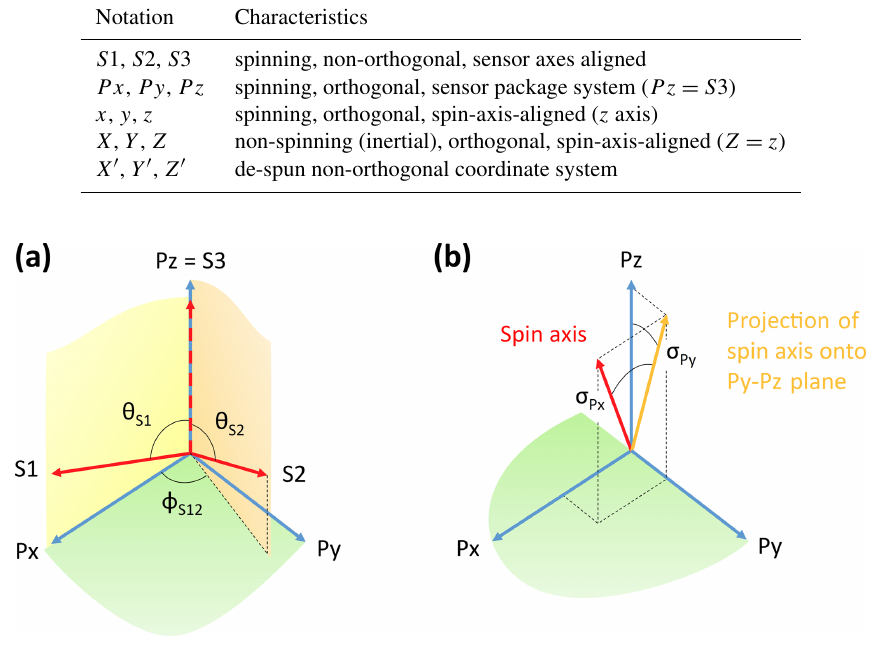
Figure 1. Sketch of the coordinate systems: (a) sensor axes in the sensor package coordinate system and (b) spin axis and rotation angles σ Px and σ Py in the sensor package coordinate